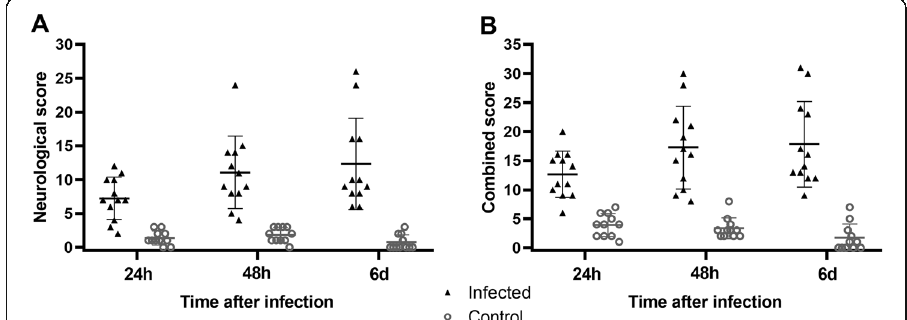
Fig. 3 Neurological score of infected rats and saline control rats. Rats were infected with pneumococci (infected; black triangles; n = 12) or with equal volume of saline (control; grey circles; n = 11). The following outcomes are reported: a neurological score as measured by the functional observational battery and b combined clinical and neurological score as measured by the functional observational battery. Lines and error bars indicate the mean and standard deviation